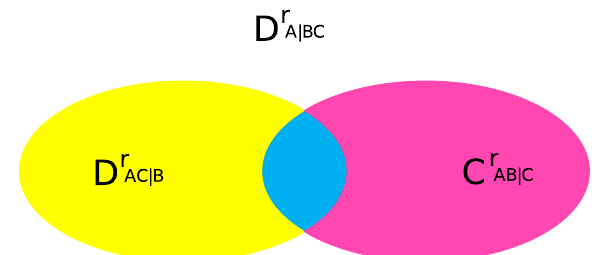
Fig. 2 The area (yellow and blue) represents the discord between AC and B , while the area (red and blue) represents the quantum correlations between AB and C . The total area (yellow, blue and red) represents the discord between A and BC . One can read off the